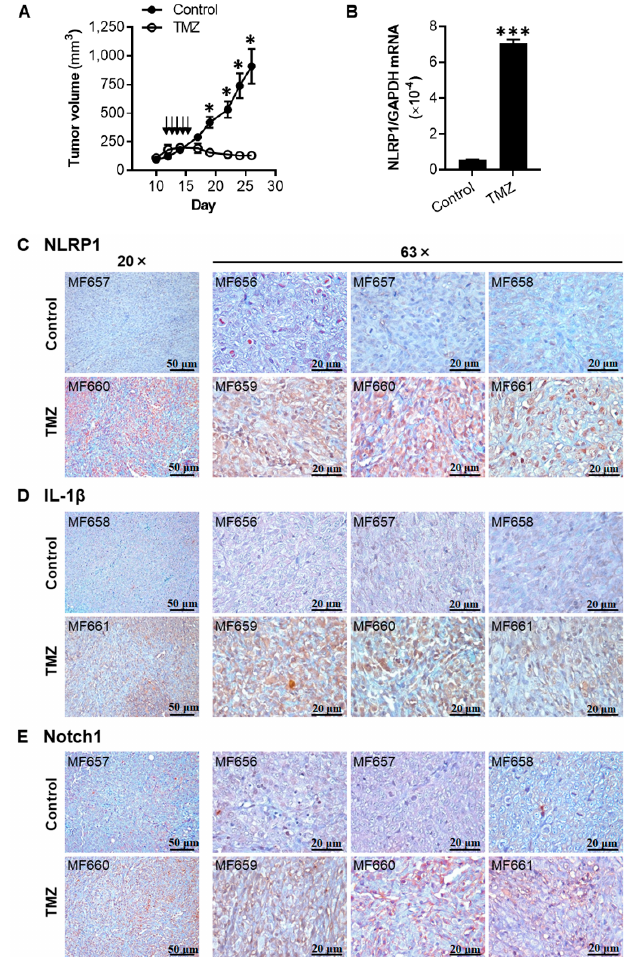
Figure 6. TMZ inhibits tumor growth and enhances the expression of NLRP1, IL-1 β , and Notch1 in 1205Lu tumors in vivo. ( A ) Tumor growth curve of 1205Lu parental cells injected subcutaneously in mice, intraperitoneally treated with a TMZ cycle or 10% dimethyl sulfoxide (DMSO) (Control) (indicated by arrows). Tumor growth was monitored for 26 days. Data are expressed as the mean ± SEM. n = 10 tumors (control) or 12 tumors